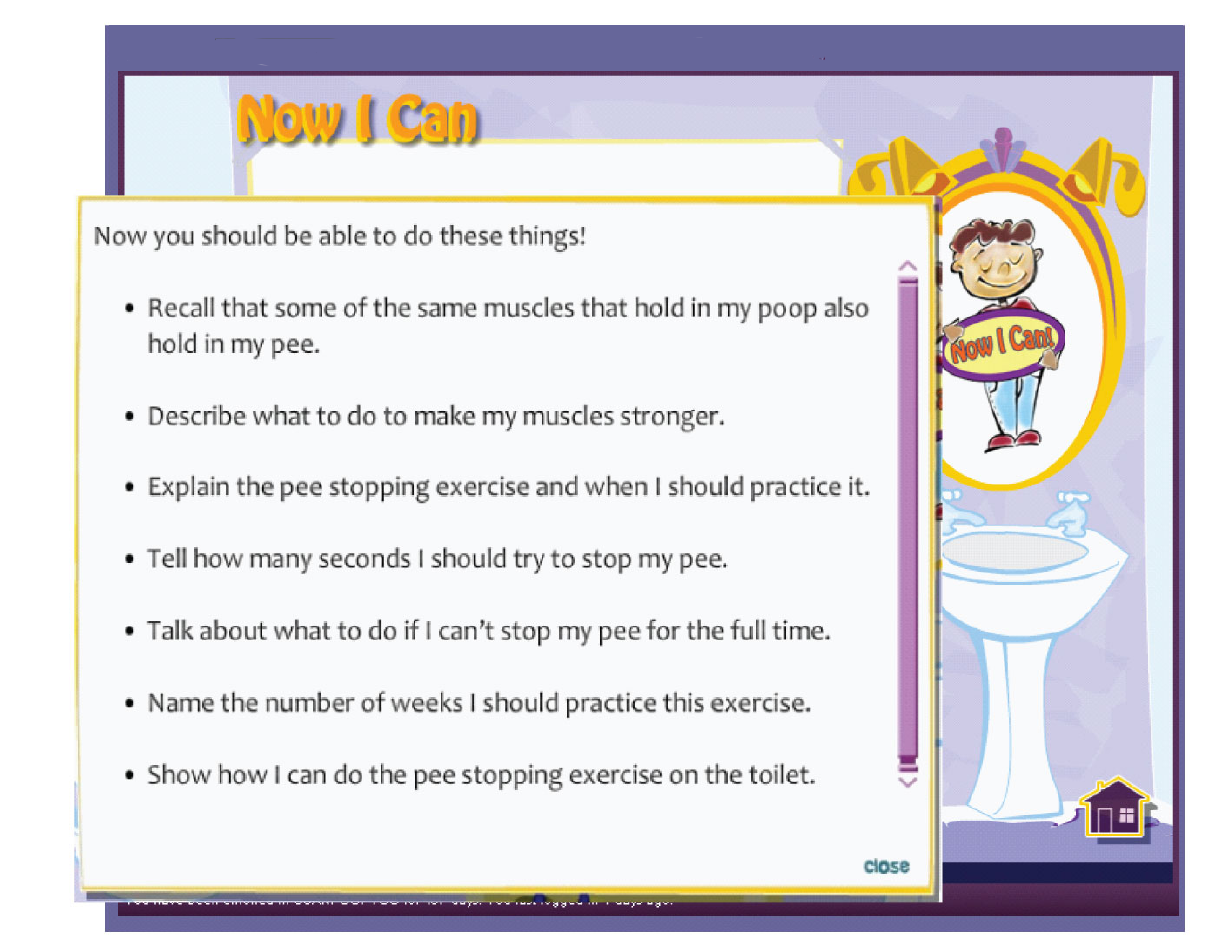
Figure 7. Now I Can screen from